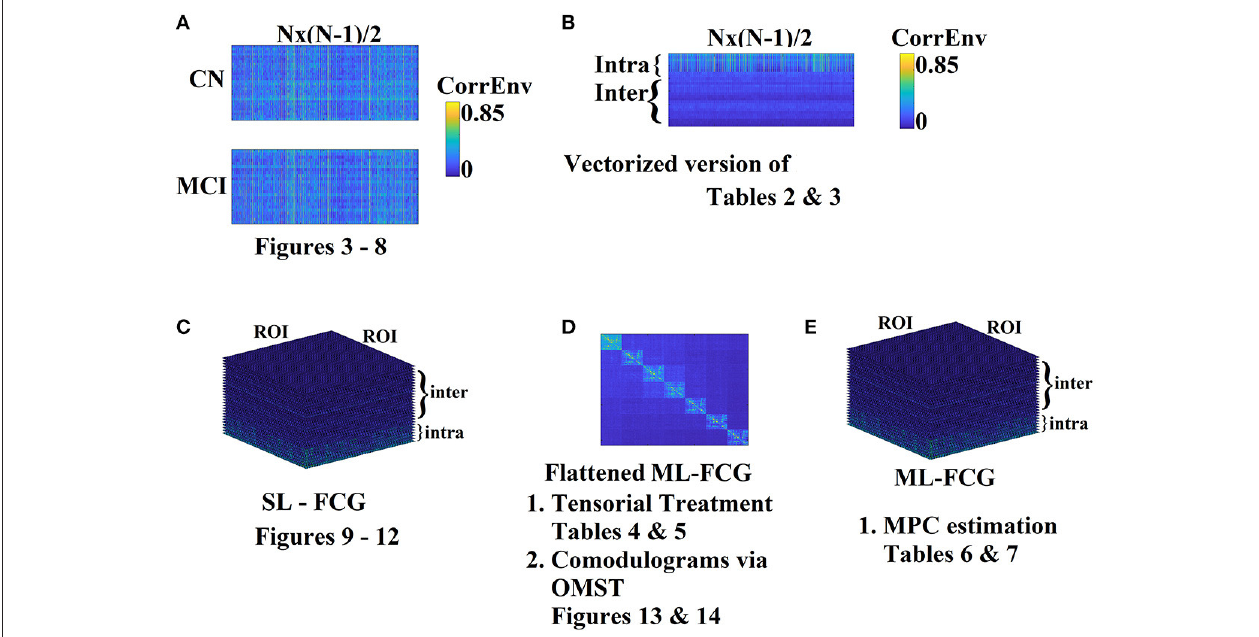
FIGURE 2 | Different Representation and analytic schemes of the multiplex functional connectivity graph (FCG). (A) Edge-weight Feature selection approach of the SL-FCG by first vectorizing each FCG to Nx(N-1)/2 list of functional connections where N denotes the number of ROIs (here N = 90). (B) Edge-weight Feature selection approach of the ML-FCG by first vectorizing each SL-FCG to Nx(N-1)/2 list of functional connections where N denotes the number of ROIs (here N = 90). The dimensions of the vectorized version of the ML-FCG is intra-inter coupling modes × Nx(N-1)/2. (C) Tensorial treatment of each SL-FCG in both intra and inter-coupling modes. (D) Tensorial treatment of the flattened version of ML-FCG where in the main diagonal are tabulated the intra-frequency FCGs and in the off-diagonal the inter-frequency FCGs. The flattened version of ML-FCG has been used for the estimation of comodulograms by filtering with our OMST data-driven topological filtering method. (E) Estimation of MPC from the ML-FCG. SL-FCG, single layer-functional connectivity graph; ML-FCG, multi-layer-functional connectivity graph; MPC, multi-layer participation coefficient.